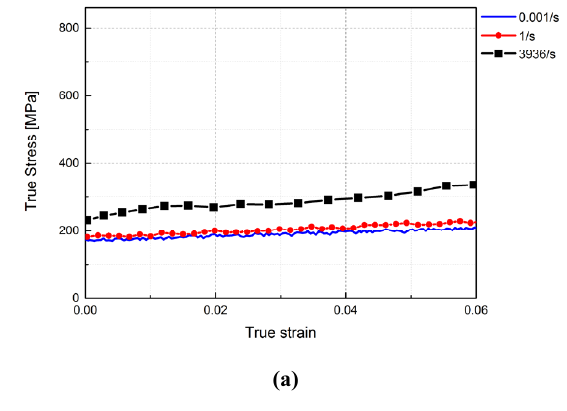
, 1h heat treated OFHC ℃